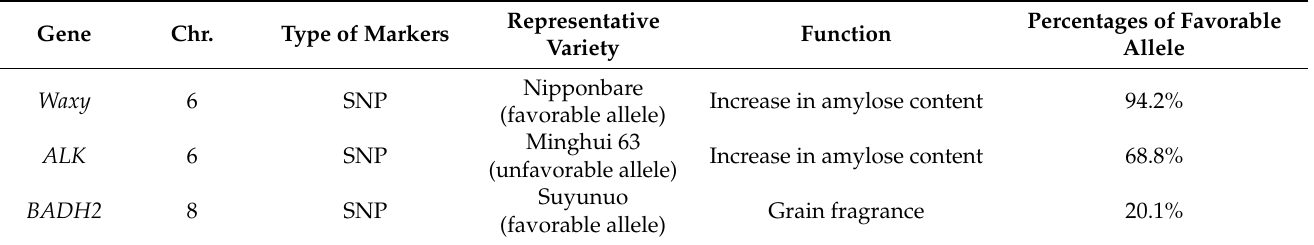
Table 2. Functional analysis of the major genes affecting the eating and cooking qualities in the collection of rice varieties.